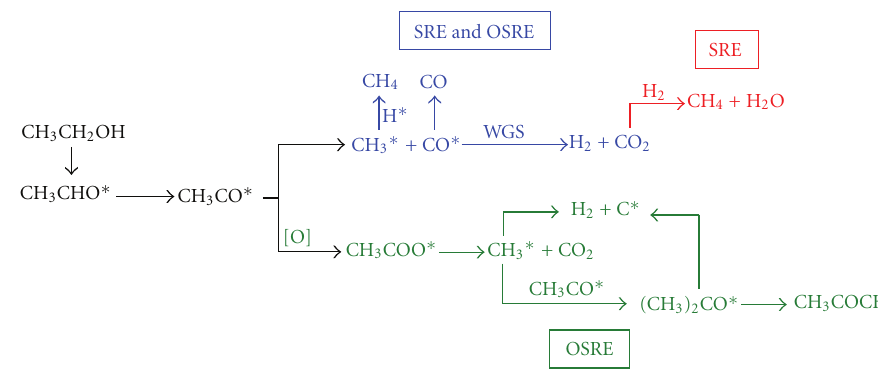
Scheme 1: Reaction routes of SRE and OSRE over PtRuMg/ZrO 2 catalyst.